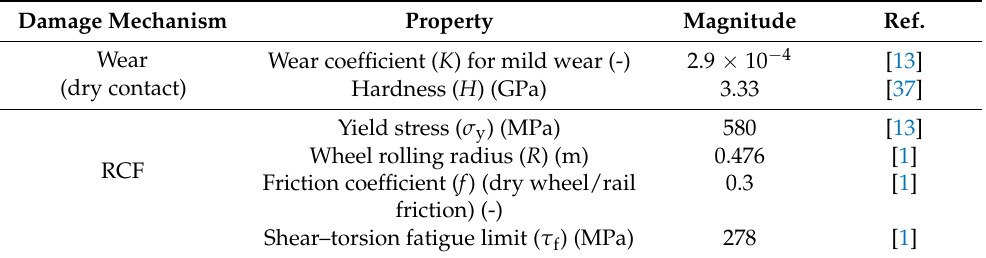
Table 2. Material properties for Mn13 in the explosion-depth-hardened and run-in state required for the wear and RCF models implemented in the simplified damage assessment tool.